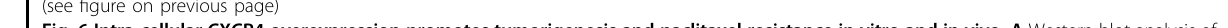
Fig. 6 Intra-cellular CXCR4 overexpression promotes tumorigenesis and paclitaxel resistance in vitro and in vivo. A Western blot analysis of CXCR4 and DR5 in doxycycline-inducible CXCR4 overexpression HCT-116 cells after treatment with different concentrations of doxycycline (1.25 μ g/ ml, 2.50 μ g/ml, 5 μ g/ml) for 48 h. β -Actin was used as an internal protein loading control. B Doxycycline inducible CXCR4 overexpression HCT-116 cells were cultured under different concentrations of doxycycline (1.25 μ g/ml, 2.5 μ g/ml, 5 μ g/ml) for 48 h. The cells were stained with